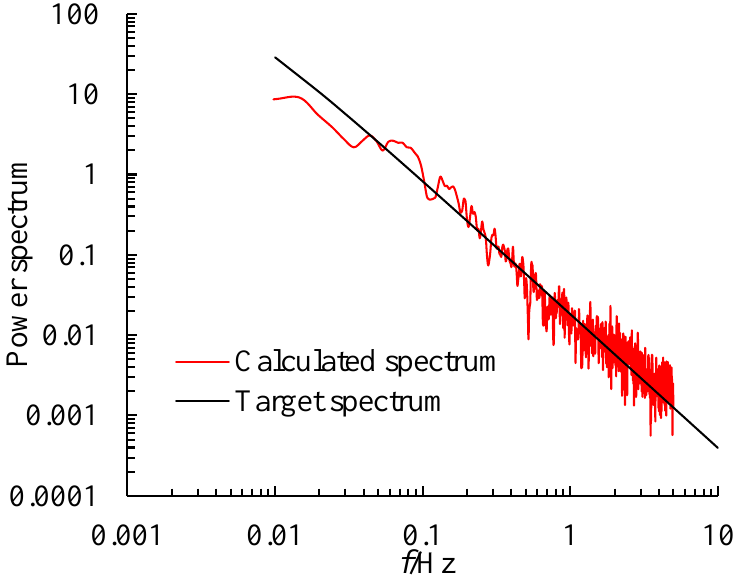
Figure 11. Comparison of the power spectrum of wind load.